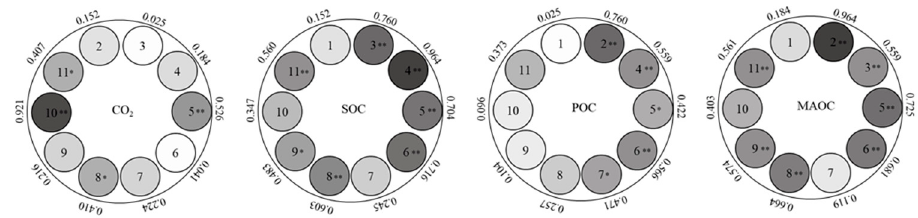
Figure 7. Correlation between soil respiration rate, soil organic carbon, and environmental factors. (Note: * indicates significant correlation at p < 0.05 level, ** indicates significant correlation at p < 0.01 level).